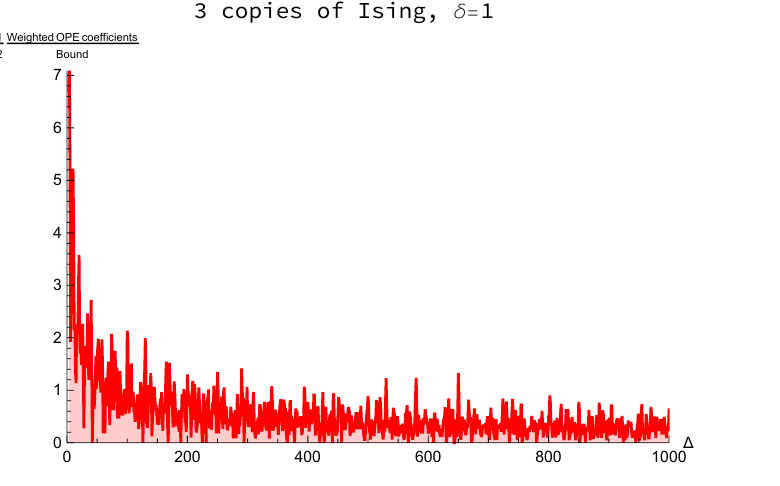
Figure 10 . The ratio of 1 operator O = (cid:15) (cid:10) I (cid:10) I